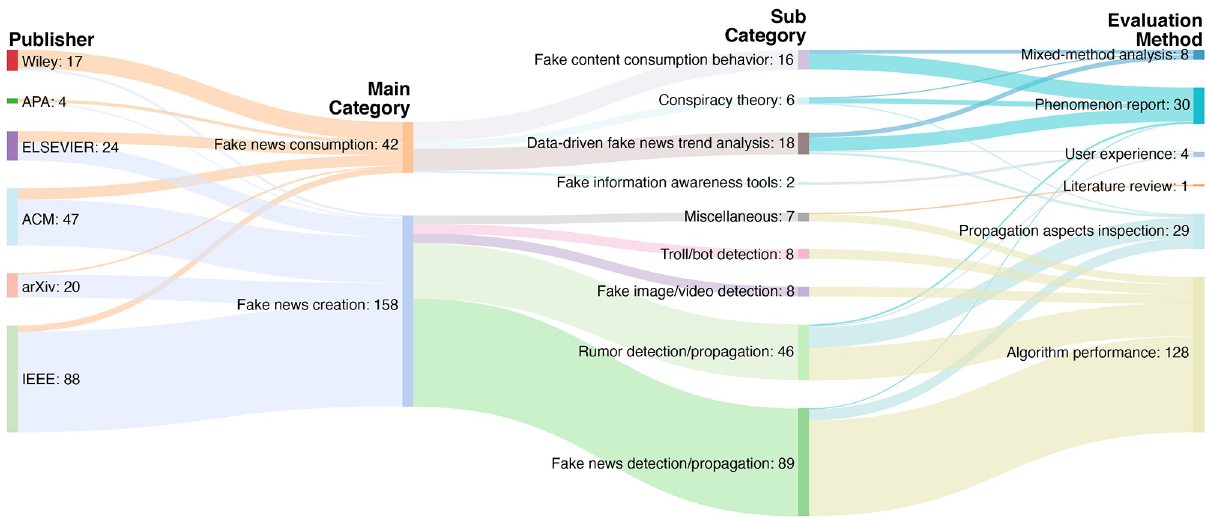
Fig 2. A visualization of 182 fake news-related papers. The papers were published in IEEE, ACM, ELSEVIER, arXiv, Wiley, APA from 2010 to 2020 classified by publisher, main category, sub category, and evaluation method (left to right).